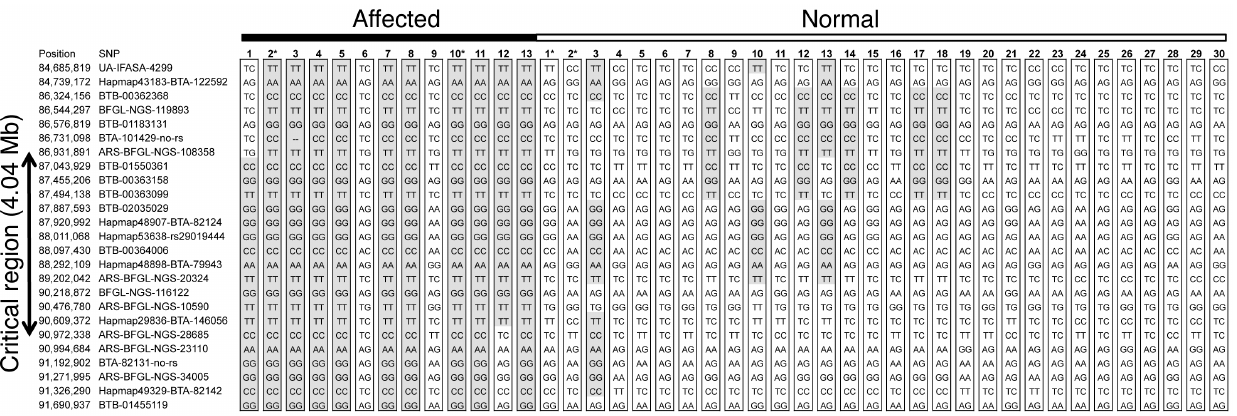
Figure 3. Genotypes of affected and normal animals for SNPs on BTA8. Overlapping blocks of extended homozygosity in the affected animals are shown in grey. The interval flanked by ARS-BFGL-NGS-108358 and ARS-BFGL-NGS-28685 (4.04 Mb) with shared homozygosity in 11/13 affected animals is determined as the critical region. In normal animals, grey blocks indicate the same homozygous haplotype shown in the affected animals with at least 6 SNPs.